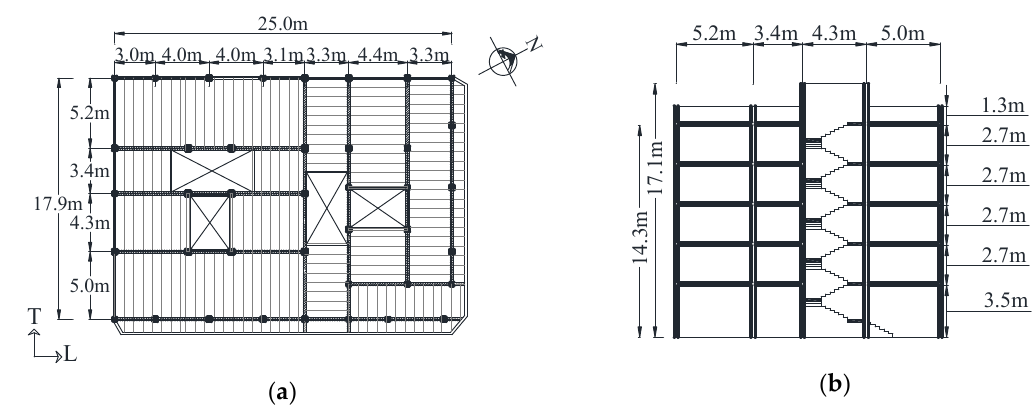
Figure 3. Geometry of the “La Viña” building: ( a ) floor plan view; ( b ) elevation view.